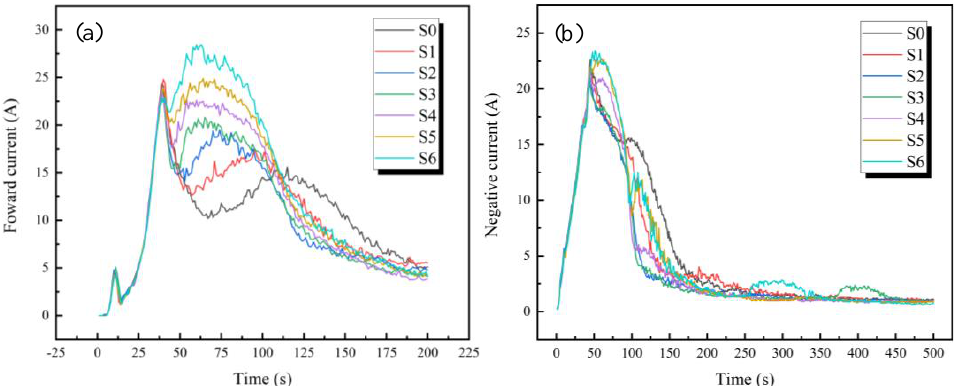
Figure 1. Current density of micro-arc oxidation: ( a ) Forward current; ( b ) Negative current.